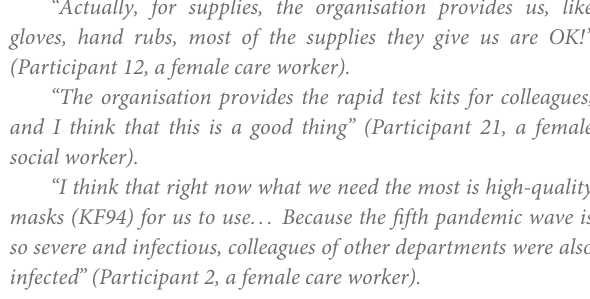
All participants ( n = 109) Mean ±